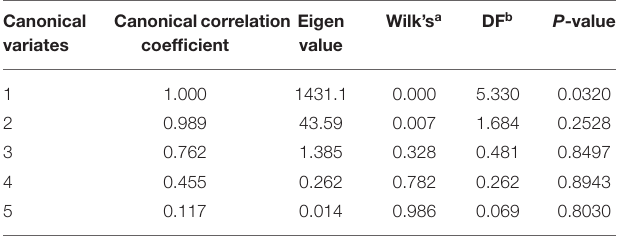
TABLE 7 | Typical correlation between heavy metal elements in the egg yolk and the ovary. Canonical variates